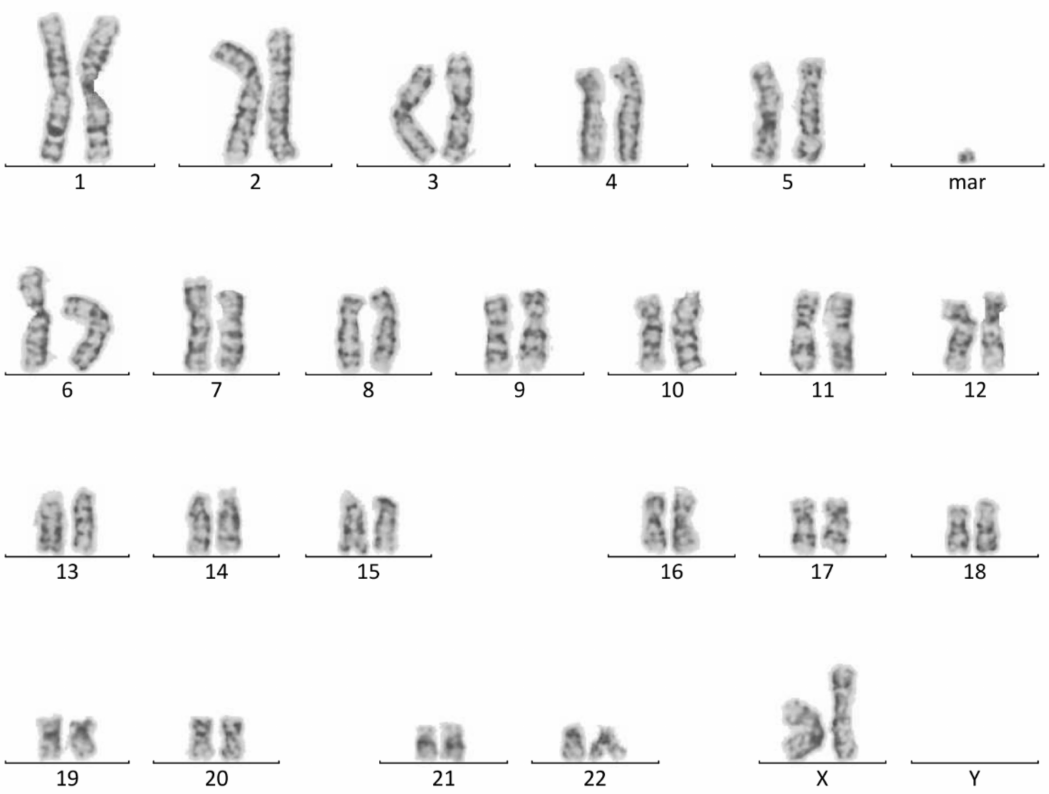
Figure 1. Karyotype 47, ХХ ,+mar. GTG banding of metaphase chromosomes from foetal cord blood lymphocytes at 20.5 weeks.